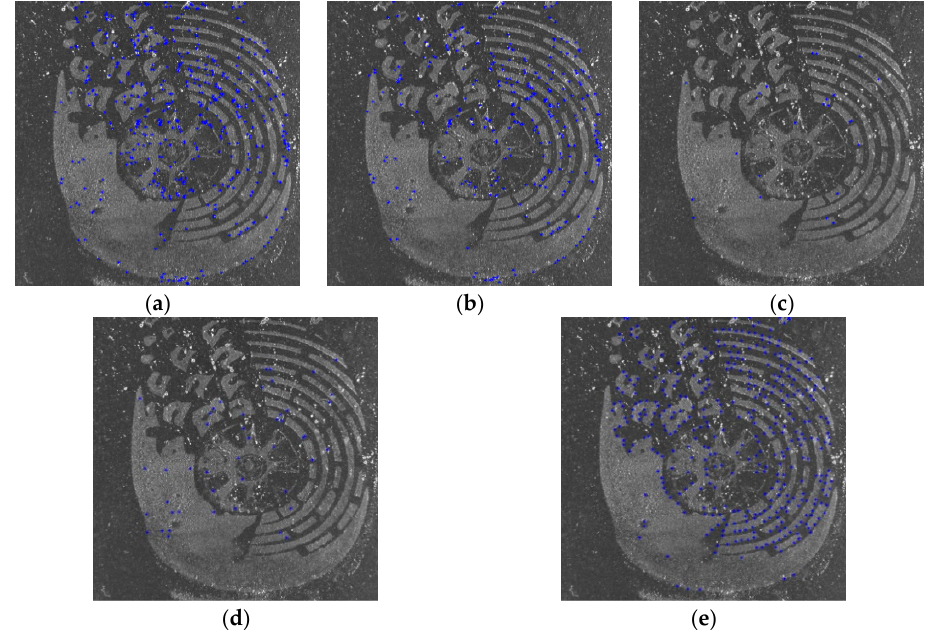
Figure 14. The results of the proposed and the compared methods on shoeprints made by the same shoe. The matched points are labeled with blue ‘*’s. The more points are labeled, which should include red circled points in Figure 12a at least, the better the algorithm performs. ( a ) The results of Harris_HOG; ( b ) the results of Harris_NCC; ( c ) the results of Shitomasi_NCC; ( d ) the results of Shitomasi_HOG; ( e ) the results of our method. Table 3. Summary of the experiments in terms of shoeprint verification performance on the MUES ‐ SV2HS2S dataset measured by the EER.